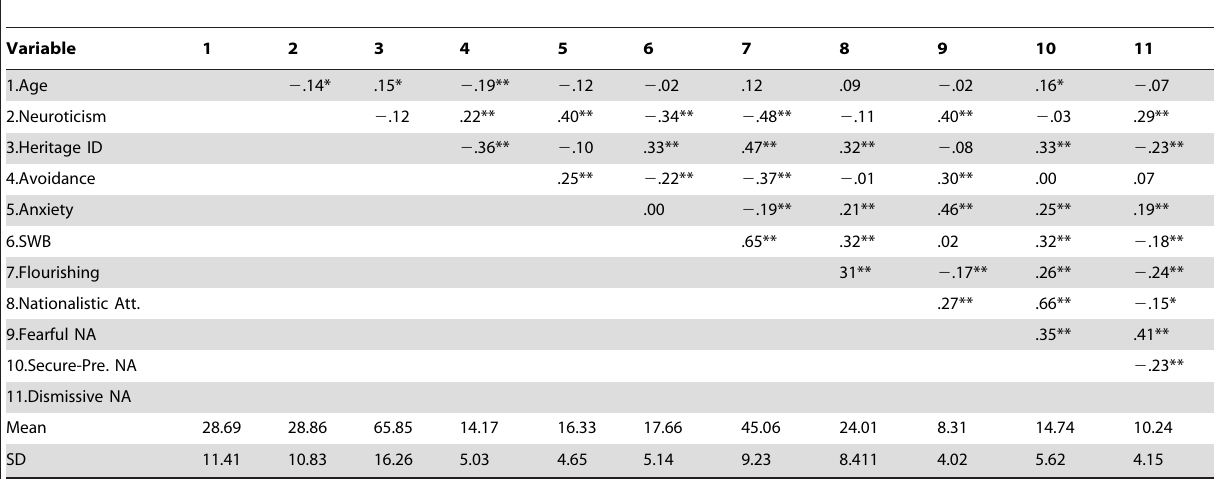
Table 6. Correlation Matrix between Variables in Study